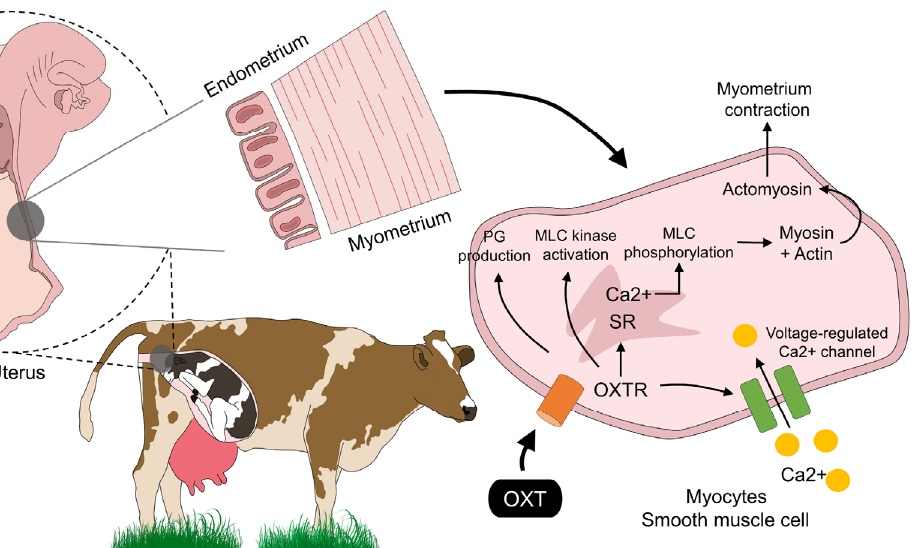
Figure 1. Oxytocin action on the smooth muscle cells in the myometrium. Endogenous and exogenous OXT promotes myometrium contraction by activation of the OXTR and its action on the voltage-regulated Ca 2+ channels that facilitate Ca influx to the cell. In the SR, the interaction of Ca 2+ participates in several events that result in muscle contraction, such as PG, production, MLC kinase activation, MLC phosphorylation, and the formation of actomyosin to maintain uterine contractions during calving: myosin light chain; MLC: myosin light-chain; OXT: oxytocin; OXTR: oxytocin receptors; PG: prostaglandin; SR: sarcoplasmic